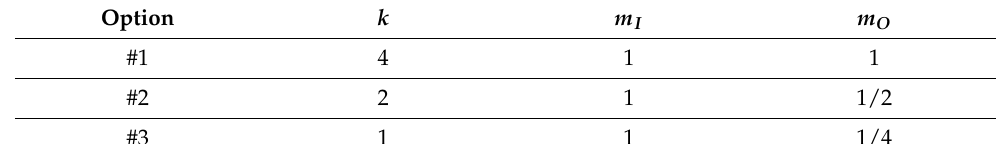
Table 1. Combinations of [ m I , m O , k ] leading to A v = 4 V/V with the same BW.